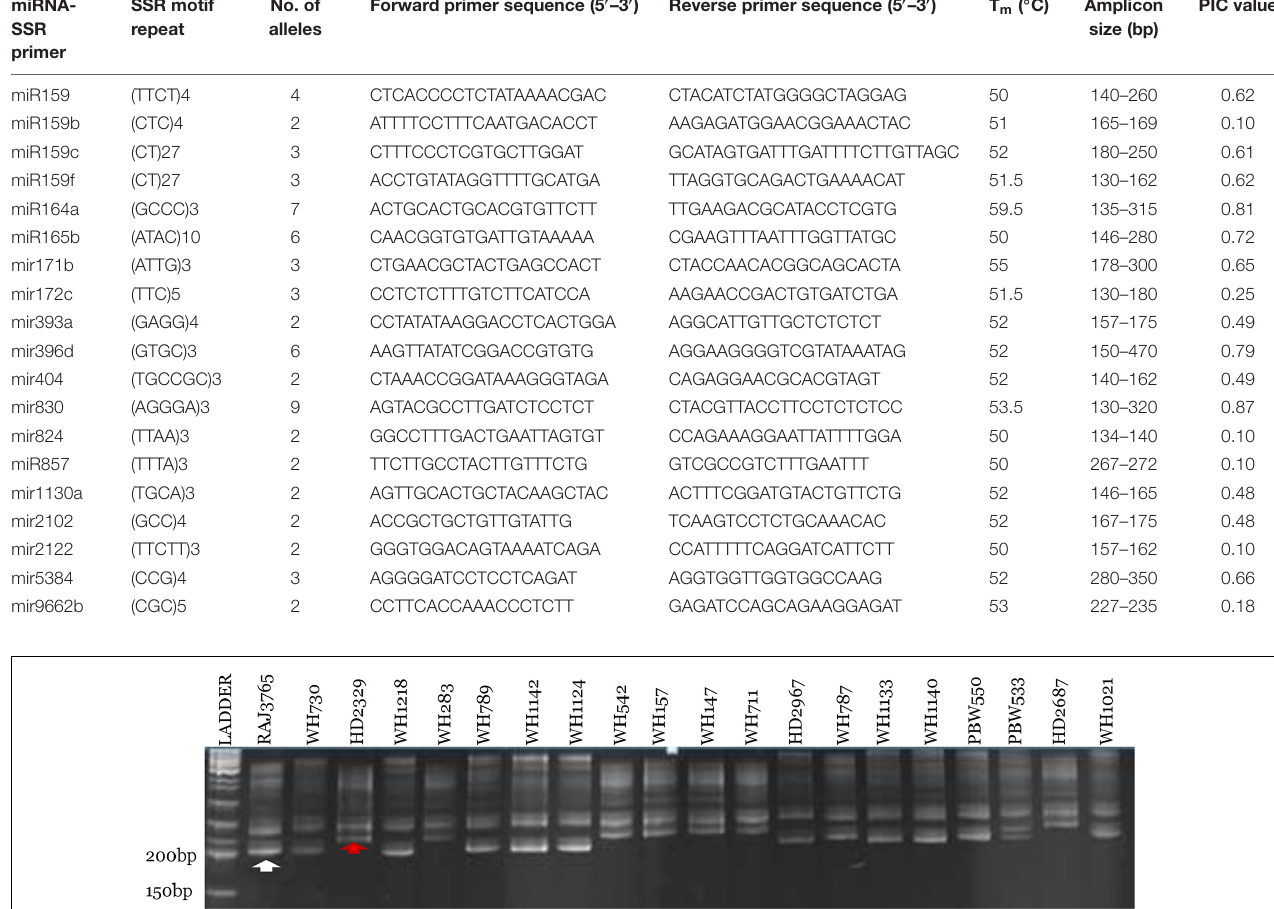
TABLE 2 | Details of 19 polymorphic miRNA-SSR markers used in the study of 20 terminal heat tolerant/susceptible wheat genotypes. miRNA- SSR